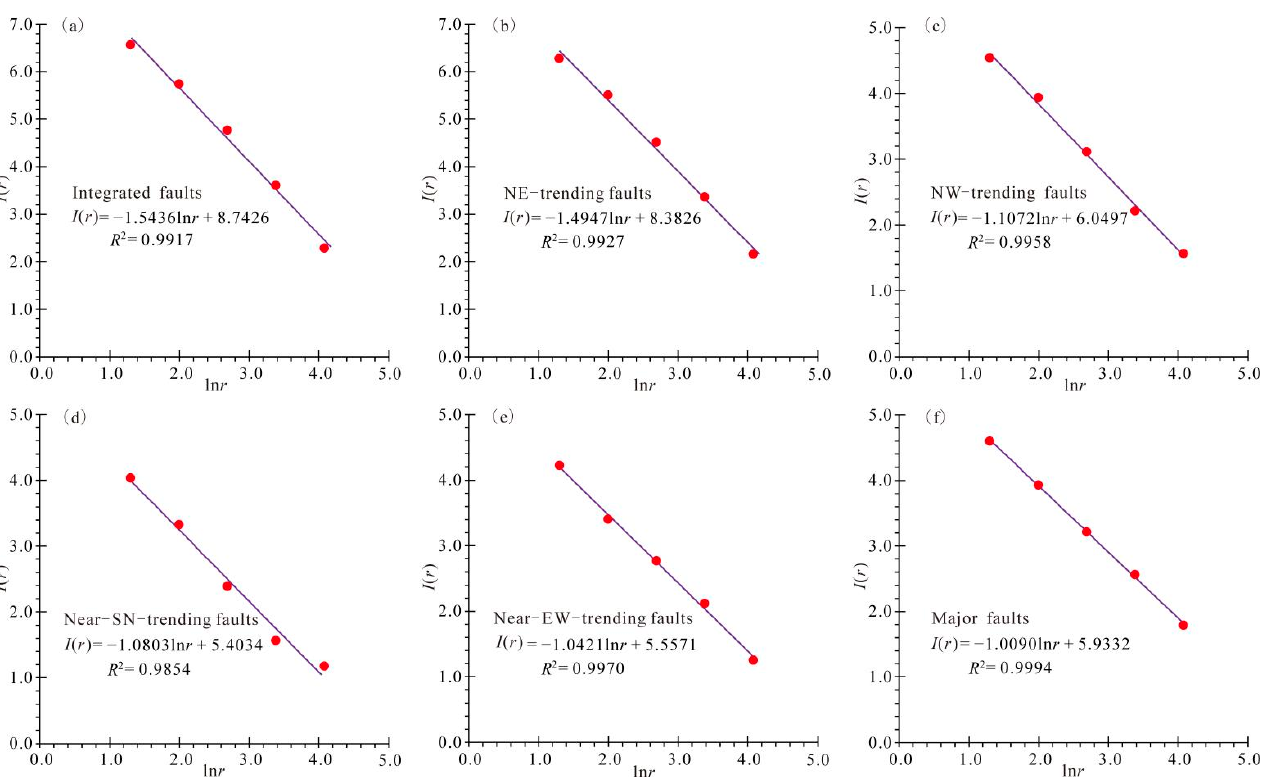
Figure 5. Linear fitting diagrams for the correlation dimension (CRD) calculation of faults in the eastern Guizhou Pb–Zn metallogenic belt (EGMB). The ln r versus I ( r ) plots of CRD data for ( a ) Integrated faults; ( b ) NE ‐ trending faults; ( c ) NW ‐ trending faults; ( d ) Near ‐ SN ‐ trending faults; ( e ) Near ‐ EW ‐ trending faults; and ( f ) Major faults, showing their linear regression parameters. Table 1. Statistical table of calculation parameters of fractal dimensions for fault structures in the Table 2. Statistical table of fractal dimension for fault structures in some areas of eastern Guizhou Pb–Zn metallogenic belt (EGMB).